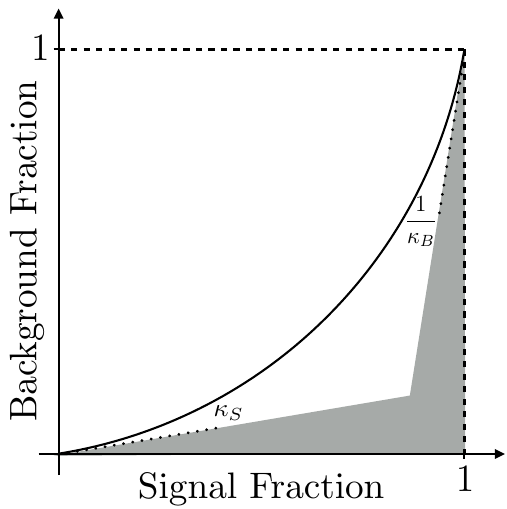
Figure 1. An illustration of the bound on the ROC curve and its AUC from extrapolating the reducibility factor slopes (cid:20) S and 1 =(cid:20) B from the endpoints. The ROC is monotonic and concave up and so the gray quadrilateral is always completely contained underneath the full ROC curve, yielding the